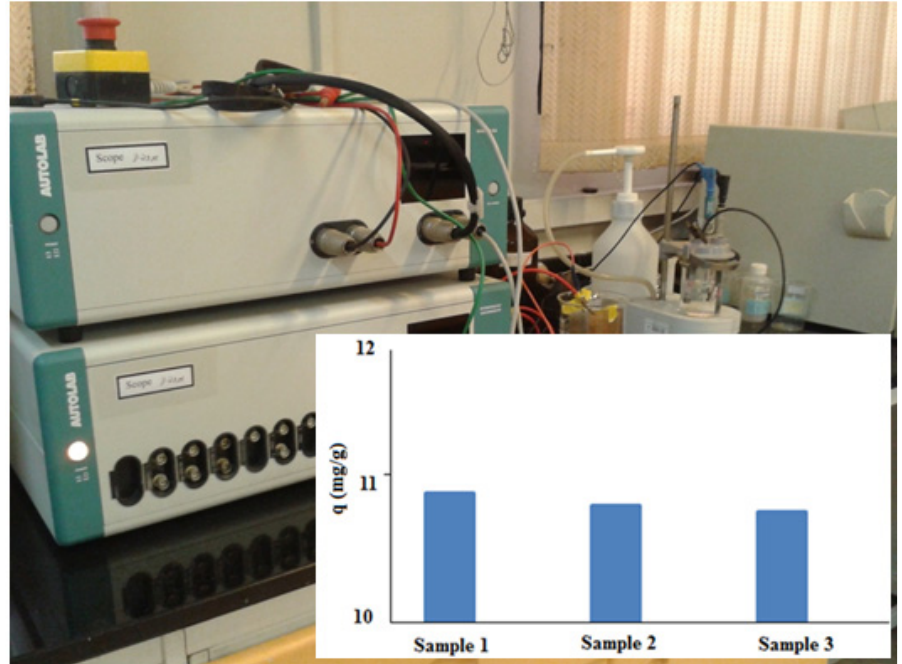
Fig. 4. Adsorption capacity of: sample1= 35 mA cm -2 , sample2= 15 mA cm -2 , sample 3= 5 mA cm